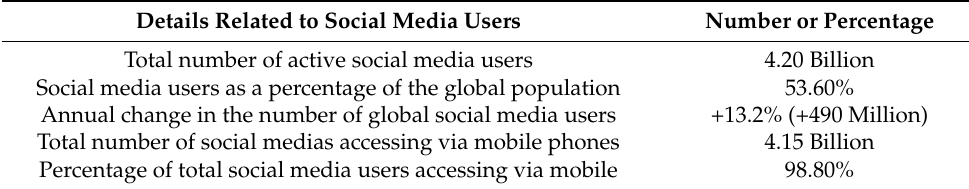
Table 1. Use social networks and messenger services worldwide in January 2021, with details for mobile social media use, according to the Digital 2021 Global Digital Overview report